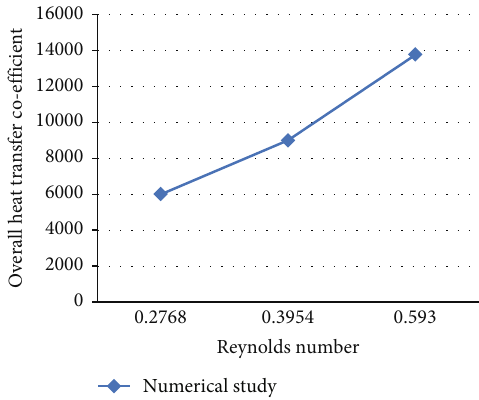
Figure 13: E ff ect of overall heat transfer coe ffi cient at di ff erent concentrations of alumina at 0.7m/sec